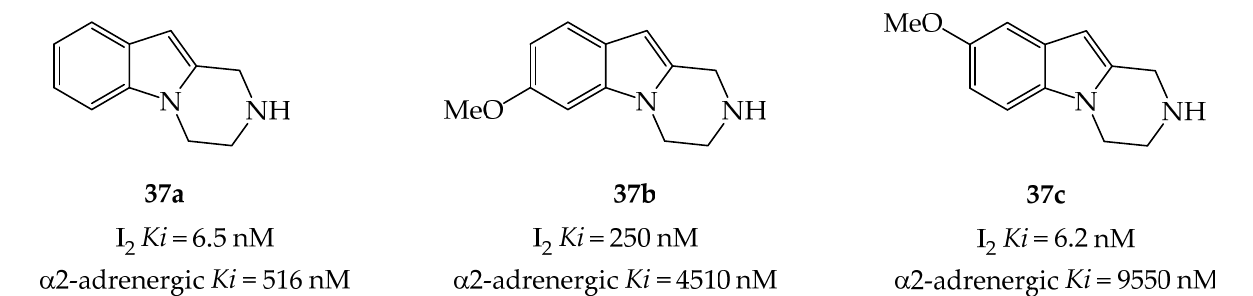
Figure 2. Tetrahydro-pyrazinoindoles 37 and their binding data at I 2 and α -adrenergic receptors. Zlotos et al. synthesized a series of C1-substituted tetrahydro-pyrazinoindoles 1